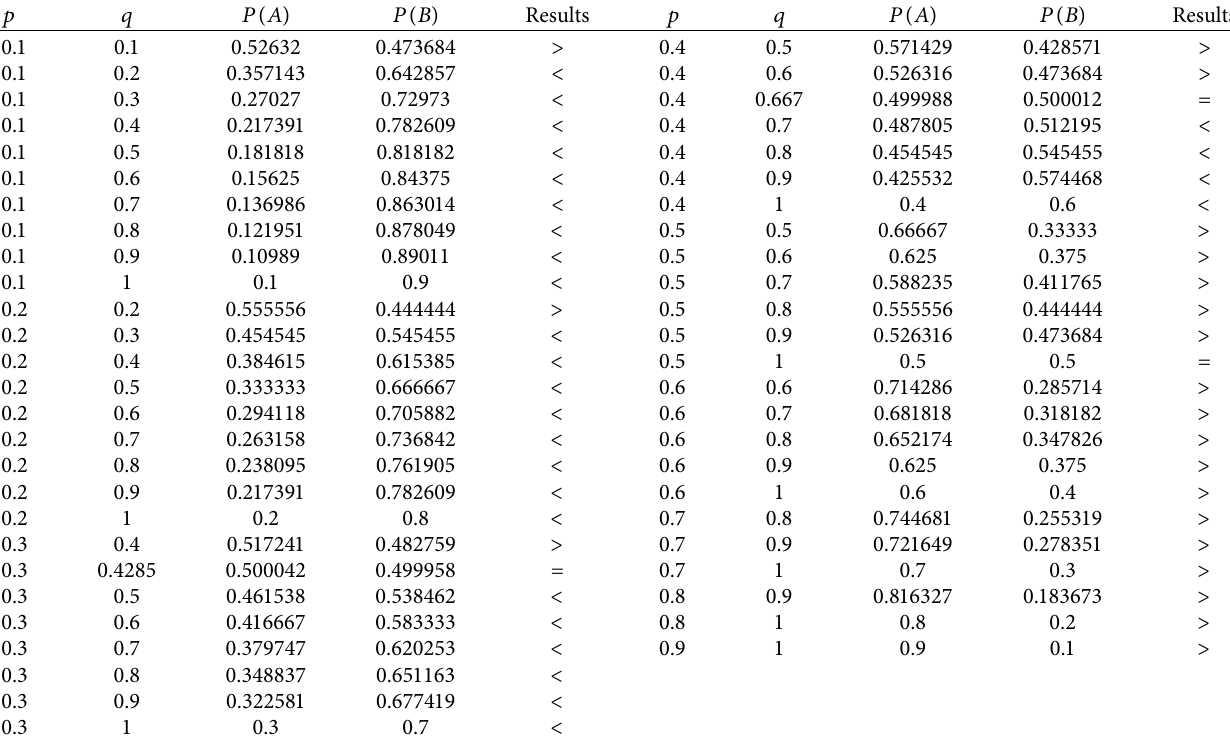
Figure 1: Equilibrium graph of the “preemptive strike” test. Table 3: The “preemptive strike” test